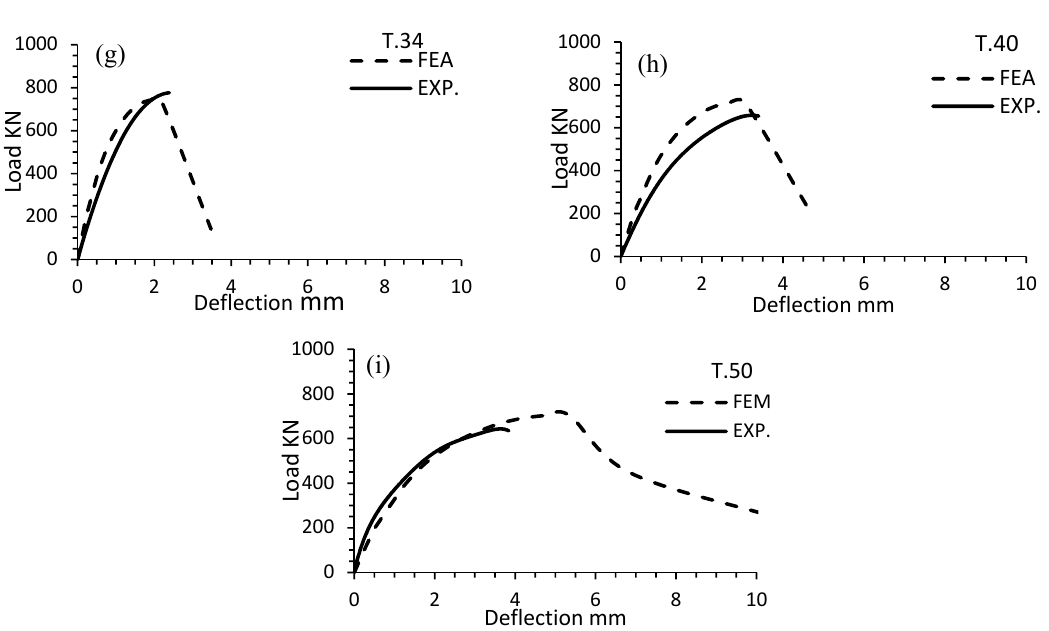
Figure 6. FE results of specimens: ( a – c ) Sq. shaped columns with di ff erent slenderness ratios; ( d – f ) + . shaped columns with di ff erent slenderness ratios; ( g – i ) T. shaped columns with di ff erent slenderness ratios